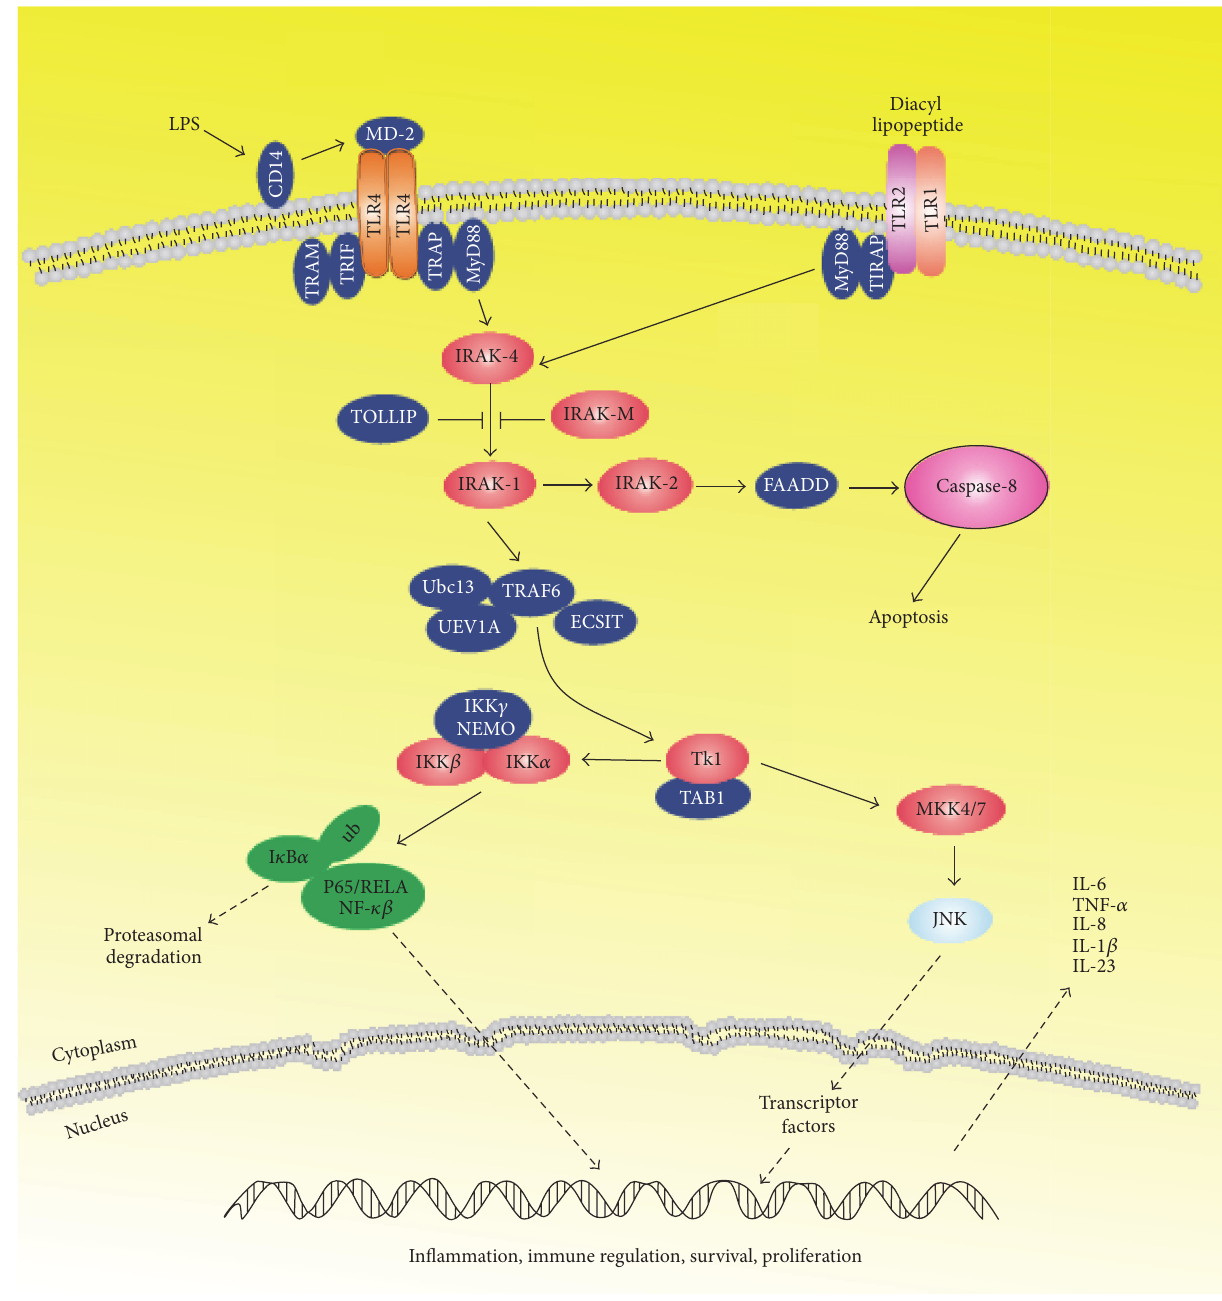
Figure 2: Toll-like receptor signaling pathways. LPS: lipopolysaccharide; CD14: cluster of differentiation 14; MD-2: lymphocyte antigen 96; TLR: toll-like receptor; TRIF: TIR domain-containing adaptor-inducing IFN- 𝛽 ; TRAM: TRIF-related adaptor molecule; TRAP: